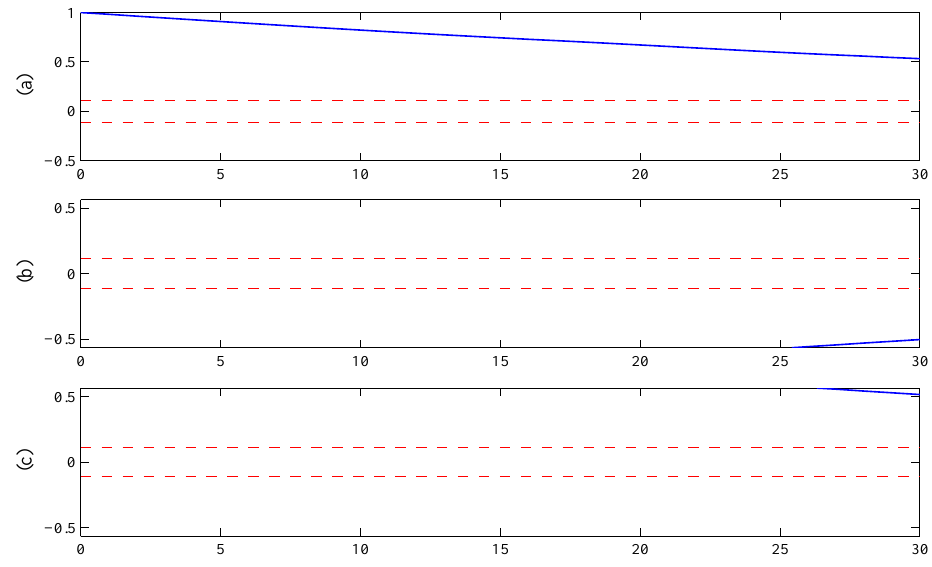
Figure 11. Model validation results of MLSLF : ( a ) φ ε (cid:48) ε (cid:48) ( τ ) ; ( b ) φ ε (cid:48) ( ε 2 ) (cid:48) ( τ ) ; ( c ) φ ( ε 2 ) (cid:48) ( ε 2 ) (cid:48) ( τ )